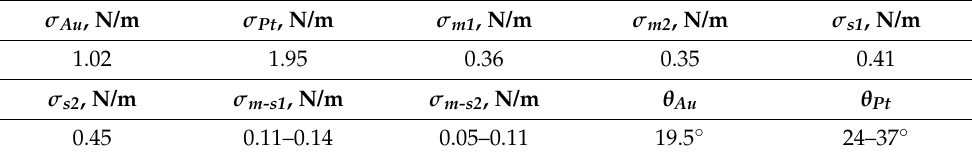
Table 3. Calculation